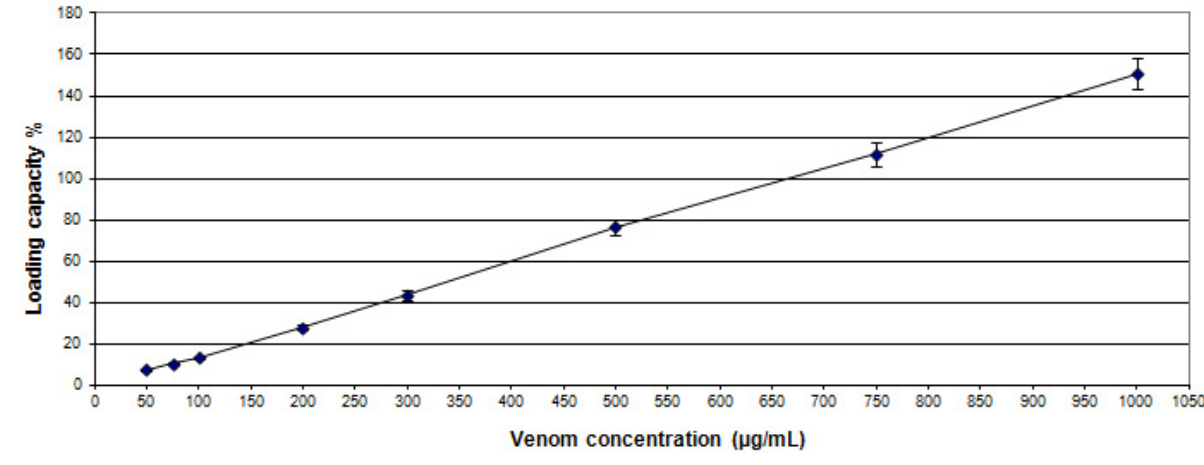
Figure 4. The influence of M. eupeus venom initial concentration on loading capacity (chitosan 2 mg/mL, TPP 1 mg/mL).